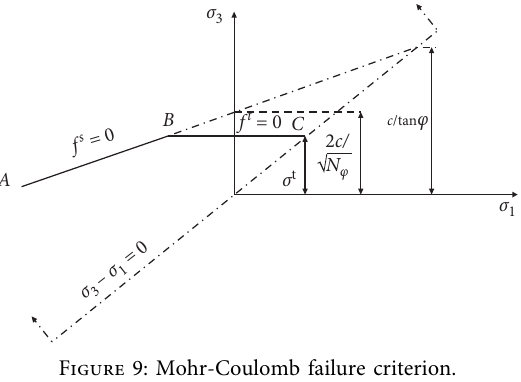
Figure 9: Mohr-Coulomb failure criterion.